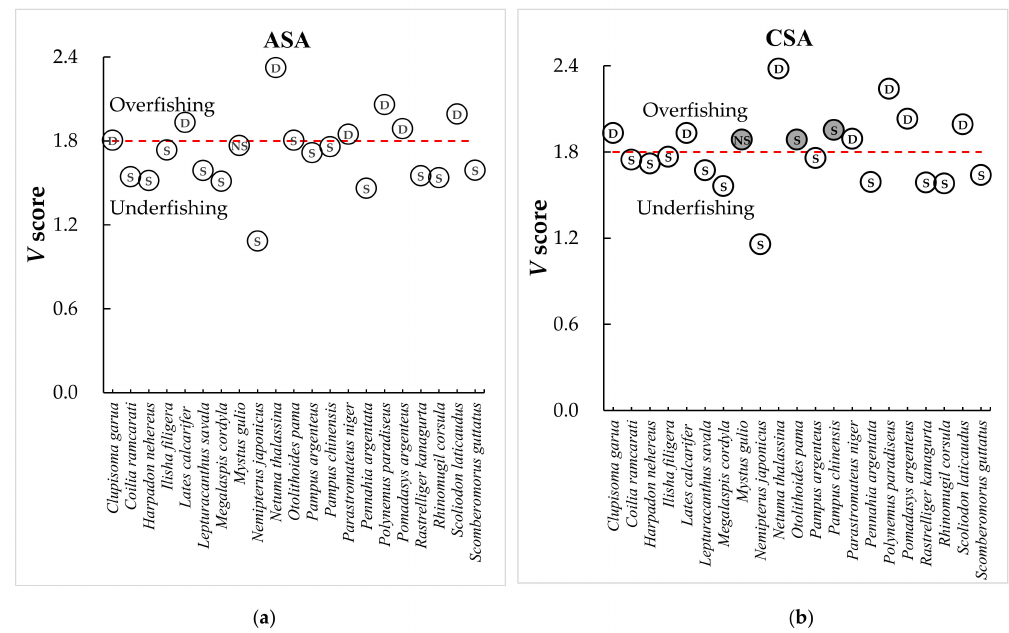
Figure 4. A comparison of the catch trends and vulnerability scores ( V scores) for the selected bycatches of the Hilsa